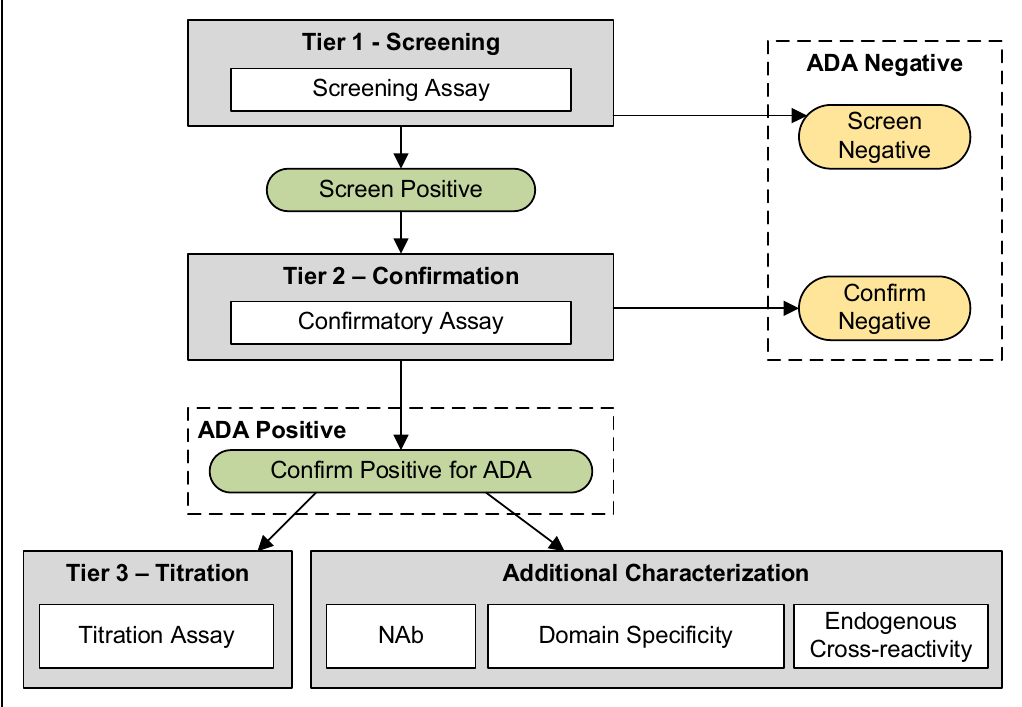
Figure 7. Generic workflow of the harmonized multi-tiered ADA sample testing scheme used to detect and characterize serum samples for the presence of reactive